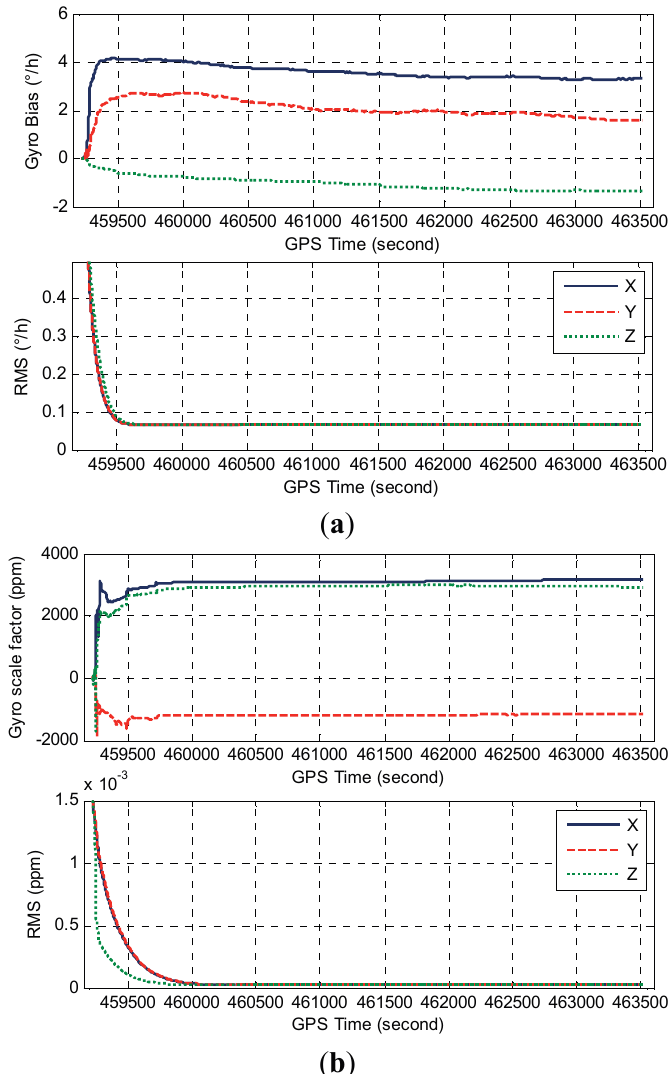
Figure 10. ( a ) Estimated gyro biases and RMS; ( b ) Estimated gyro scale factors and